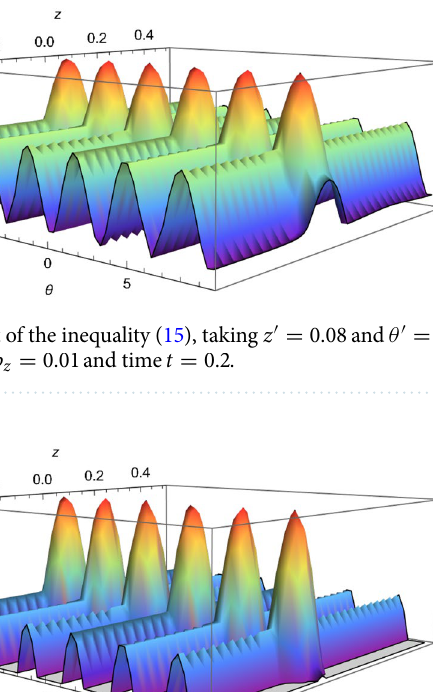
Figure 4. Inset of Fig. 3, for the values of B z from 2 to